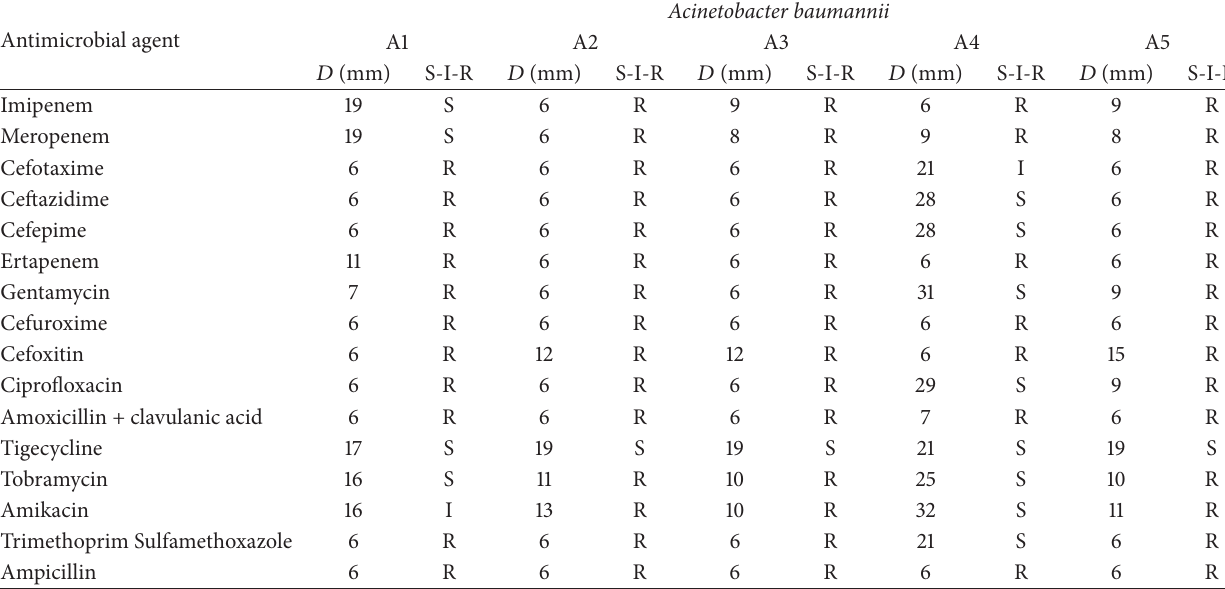
Table 1: Antibiotic Susceptibility Testing for Acinetobacter baumannii . Antimicrobial